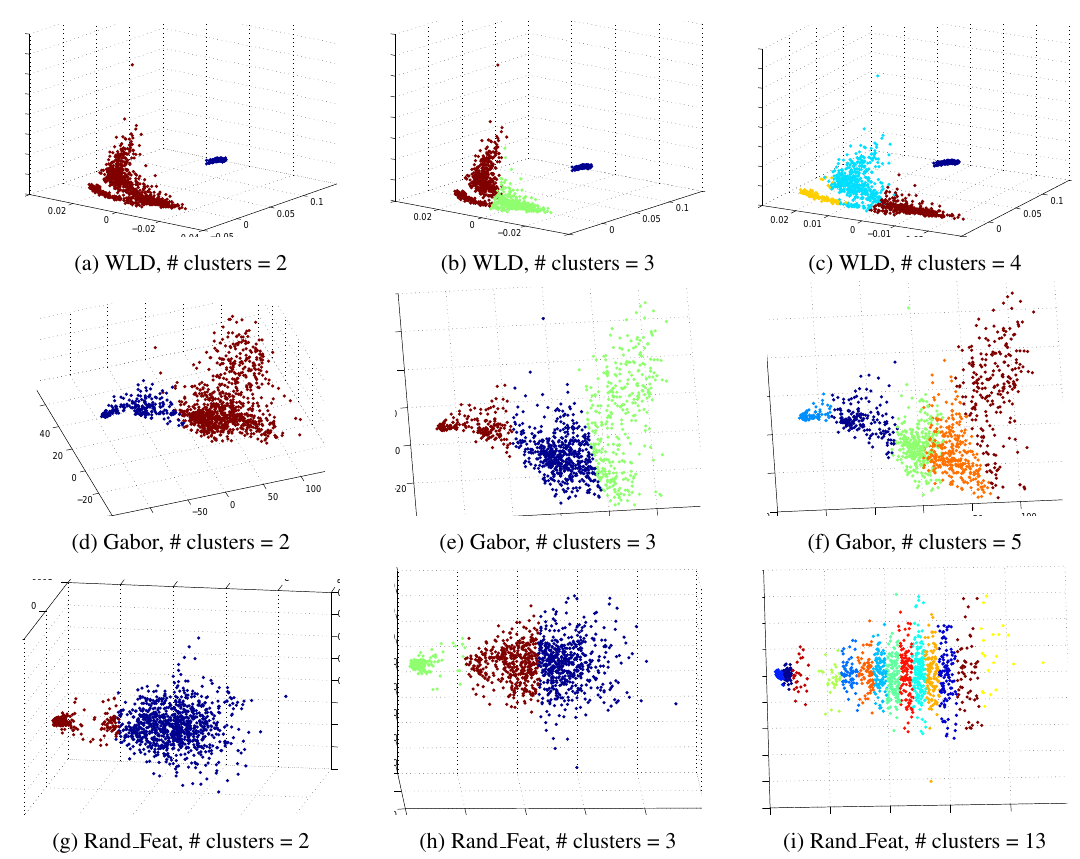
Figure 4: 3D visualization of feature space for three kinds of feature descriptors (e.g., WLD, Gabor, Rand Feat) including colored labeling for different